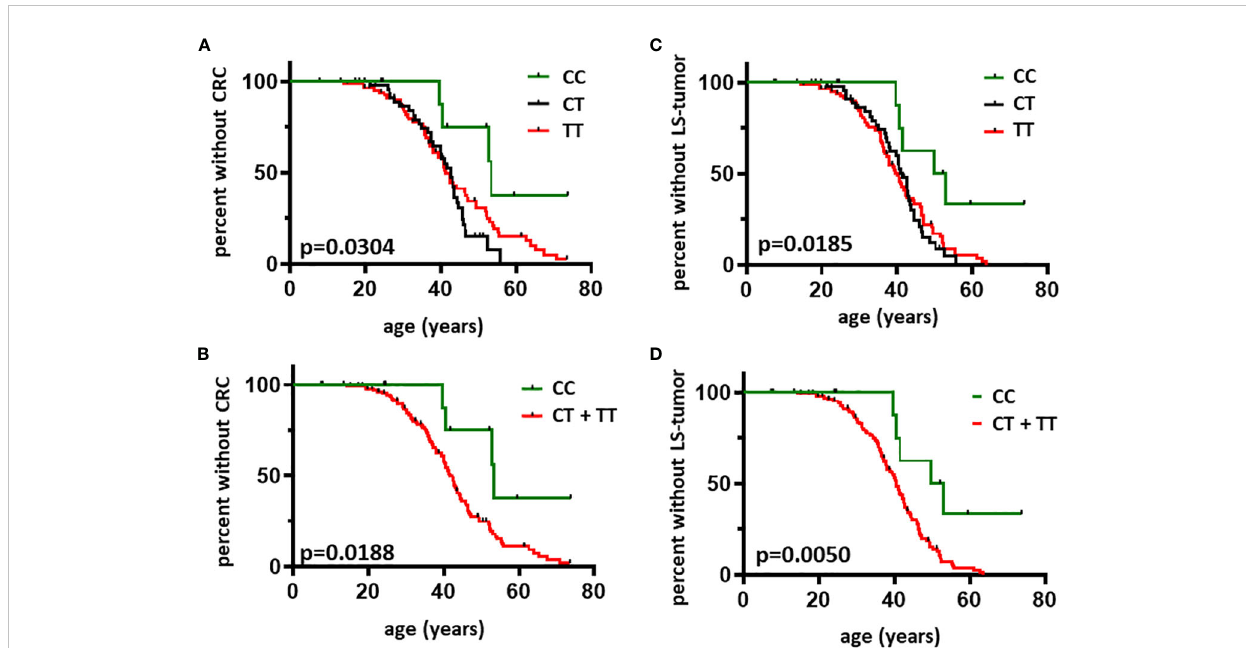
FIGURE 2 Age-related occurrence of CRC and LS-associated tumors in individuals with LS according to rs8192917 genotype Kaplan-Meier curves were plotted to visualize the fi rst CRC diagnosis based on CC vs. CT vs. TT genotypes (Panel A ) and CC vs. CT + TT genotypes (Panel B ). Kaplan-Meier curves were plotted to visualize the fi rst LS-associated tumor diagnosis based on CC vs. CT vs. TT genotypes (Panel C ) and CC vs. CT + TT genotypes (Panel D ). LS-associated tumors included malignant tumors of the gastrointestinal tract (CRC, gastric cancer, pancreatic cancer, cancer of the small intestine and of the bile ducts), endometrial cancer, ovarian cancer, malignant tumors of the urinary tract and keratoacanthomas of the skin. Curves were compared by log-rank test. n = 145. P-values < 0.05 were considered statistically signi fi